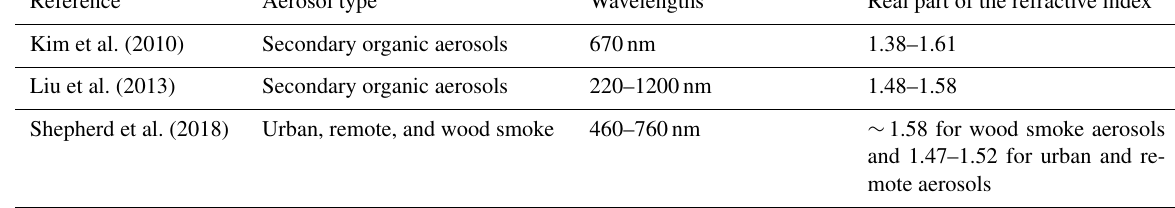
Table 1. Examples of reported real part refractive index of biomass burning and dust aerosols from previous studies and the current study.